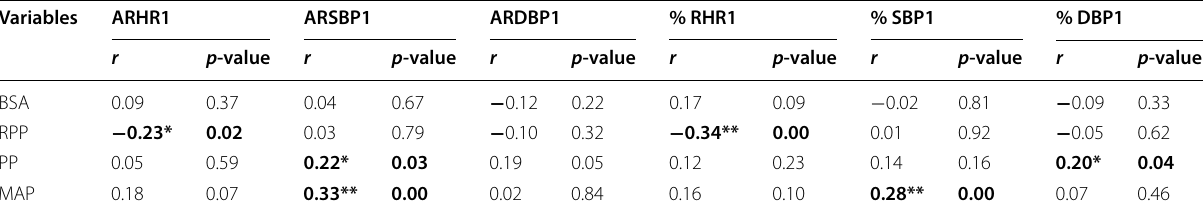
Table 2 Relationship between body surface area, derived cardiovascular indices, and recovery heart rate/blood pressure 1 min after removal of exercise